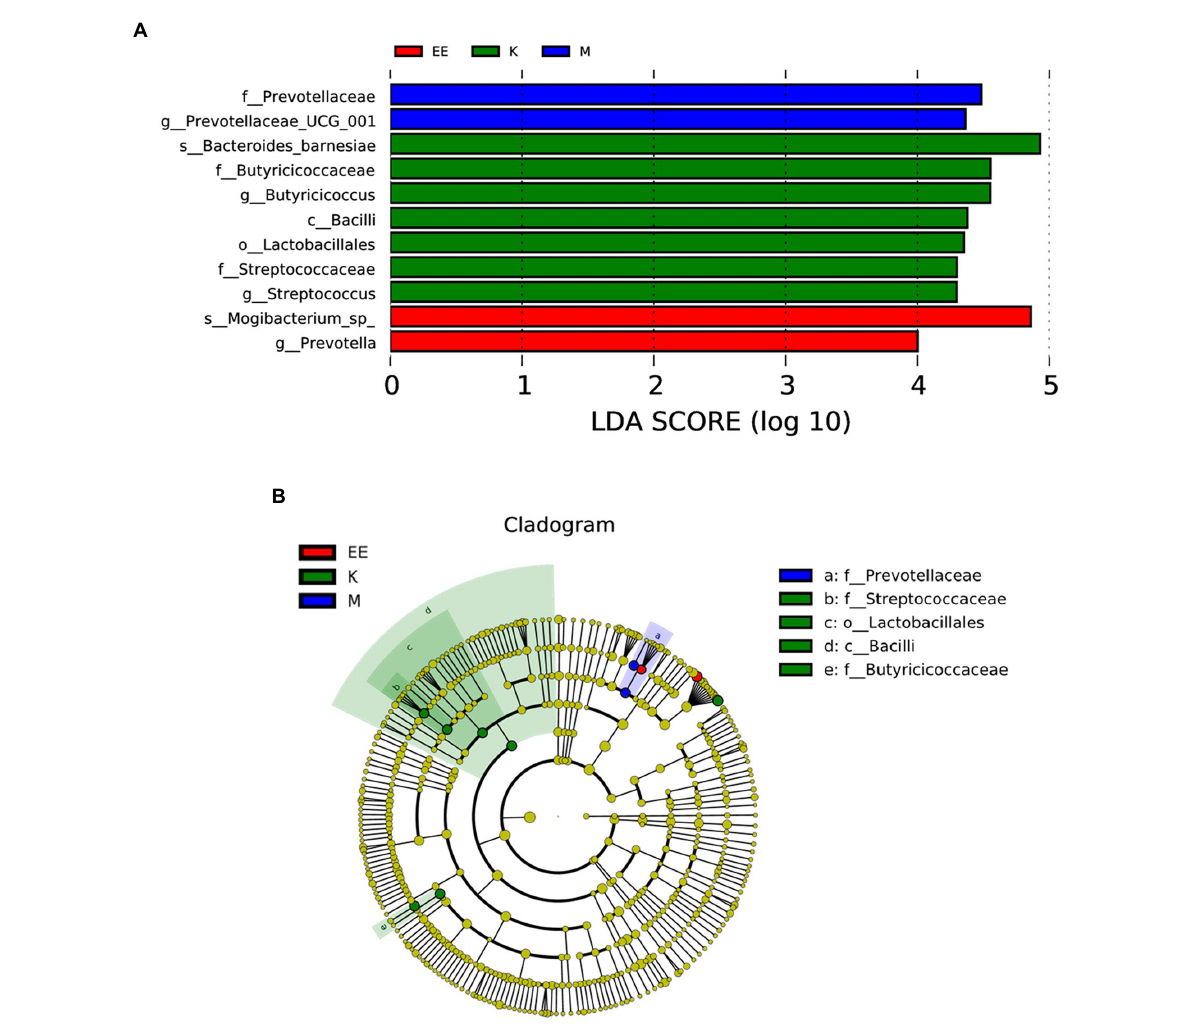
FIGURE 5 Analysis of species differences between groups. (A) Histogram of the distribution of LDA values; (B) Evolutionary branching plots, N = 5. Species with LDA scores greater than the set value (set to 4 by default), biomarker with statistical differences between groups, are shown in the histogram of the LDA value distribution. In the evolutionary branching diagram, the circles radiating from inside to outside represent the taxonomic rank from phylum to genus (or species). Each small circle of a different taxonomic level represents a taxon of that level, and the size of the diameter of the small circle is proportional to the relative abundance